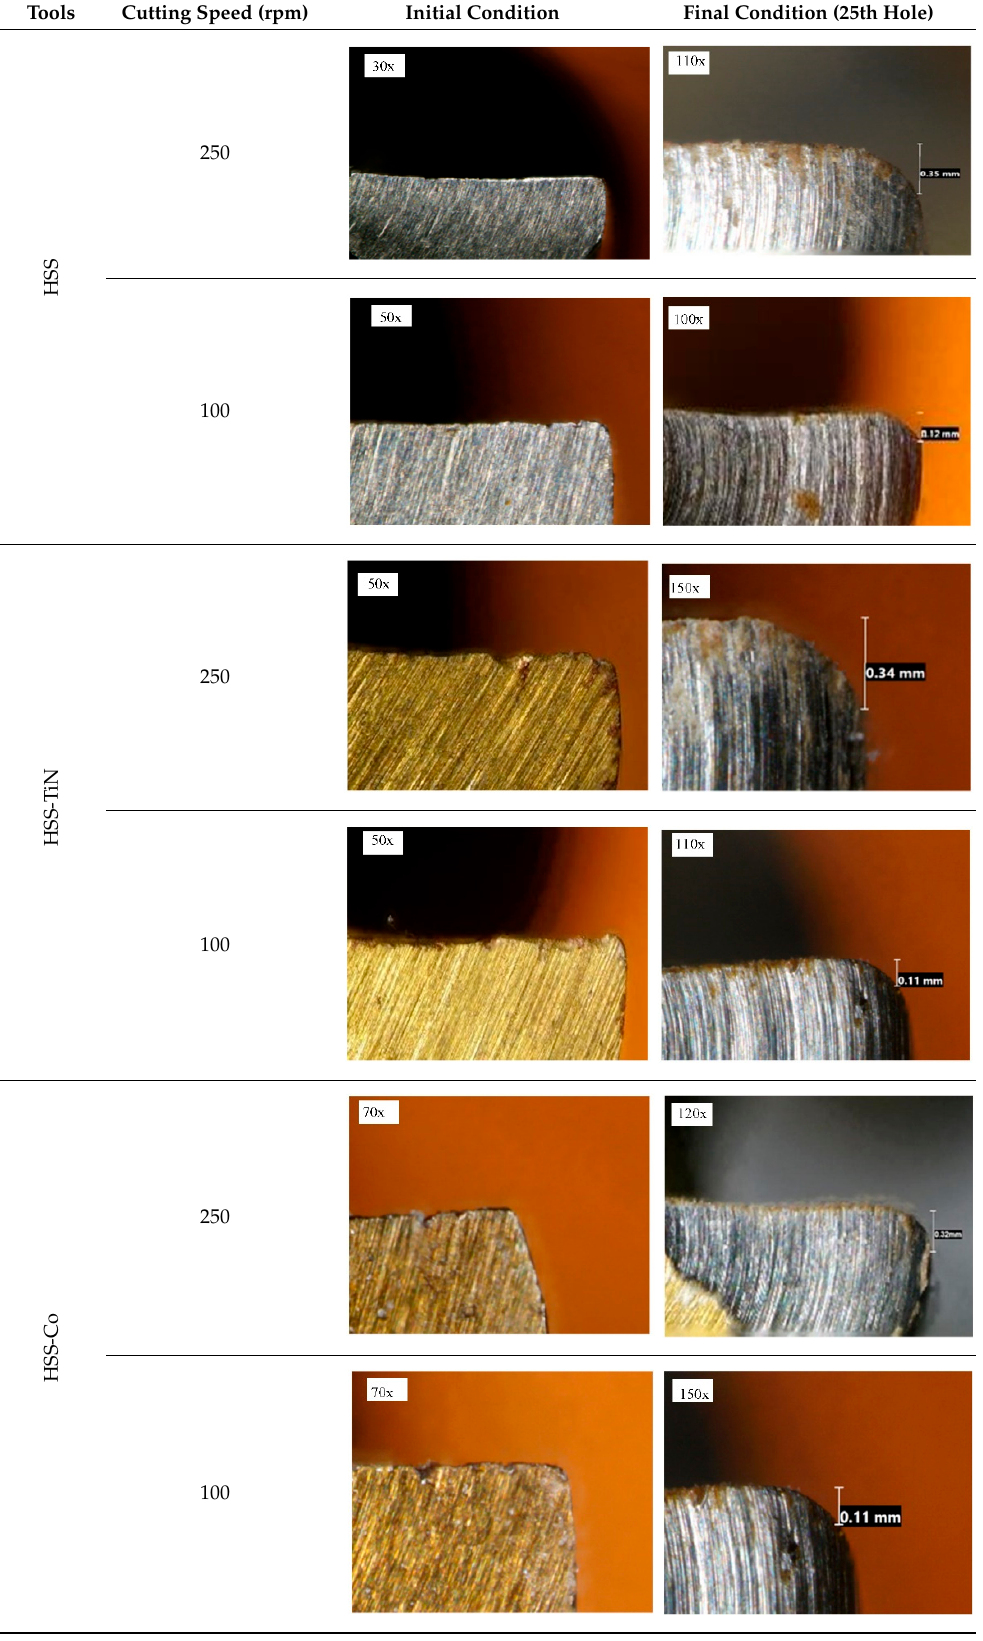
Table 4. Images of flank wears gradually emerge on HSS, HSS-TiN, and HSS-Co under a microscope magnification scale from 30 × to150 × .